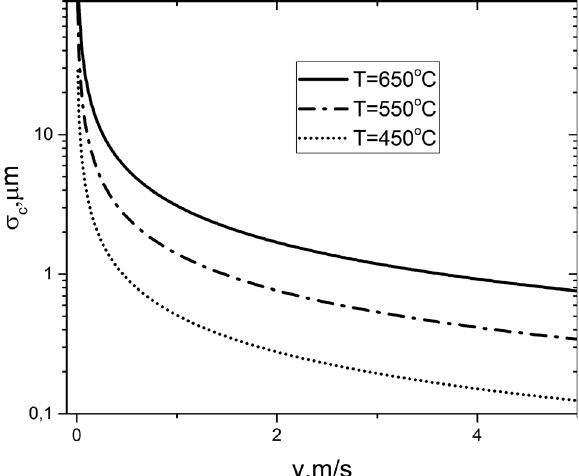
Figure 4. The value of the parameter of dissolution (corrosion) of the film (see equation (34)) depending on the hydraulic diameter. Figure 5. Dependence of the saturation thickness of the oxide film on the coolant velocity at a basic oxygen concentration of 10 -8